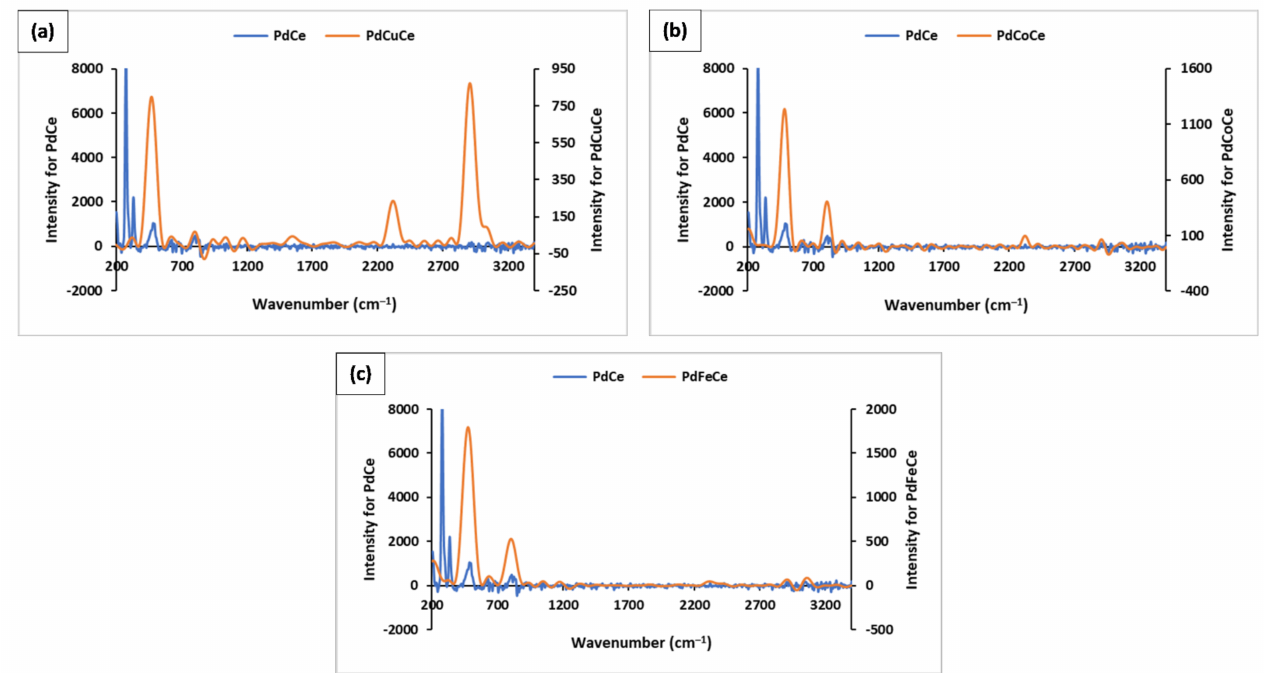
Figure 3. Raman spectra (orange) of ( a ) Pd-CuO/CeO 2 , ( b ) Pd-Co 3 O 4 /CeO 2 , and ( c ) Pd-Fe 2 O 3 /CeO 2 catalysts. The Raman spectrum of Pd/CeO 2 (blue) is included in all spectra for